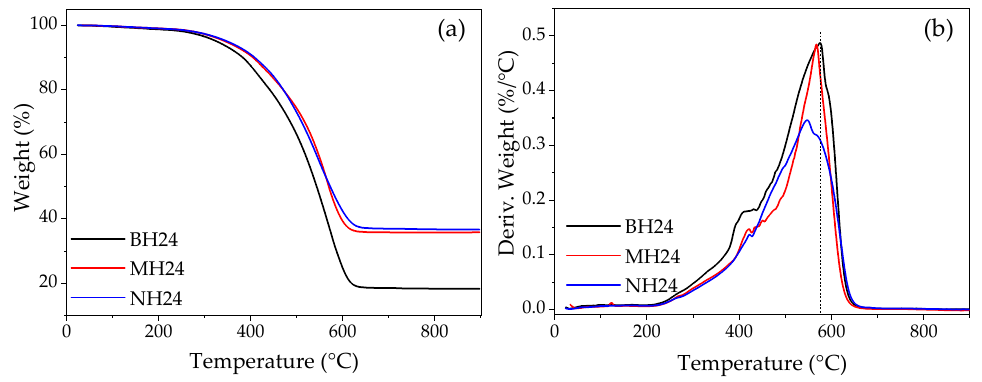
Figure 14. ( a ) TGA thermograms; ( b ) DTGA curves of MRE manufactured using a hard matrix and high SO volume.